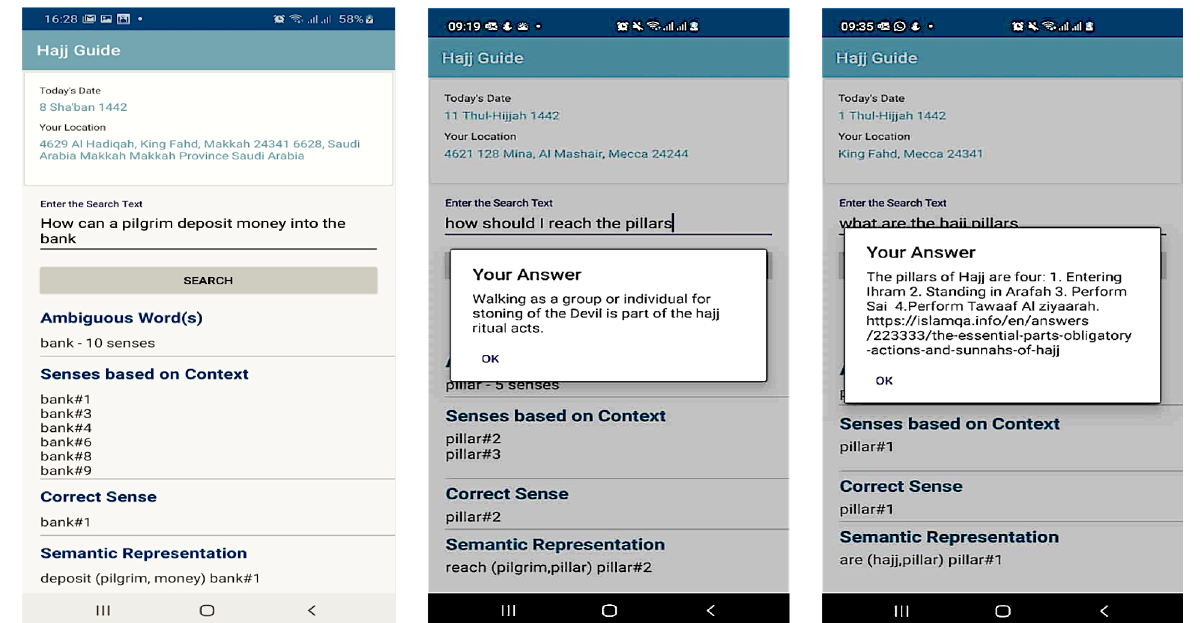
Figure 8. Semantic analysis processing tasks of posed NL questions via UI of a mobile application QA prototype. These include: the polysemous word, number of senses based on the context of the NL question, the correct sense identified, and the semantic representation. The figures also include two NL questions contain “pillars” as a polysemous word. Although “pillars” in this context has different senses, the system were capable to determined the correct sense for each posed question and returned the correct answer